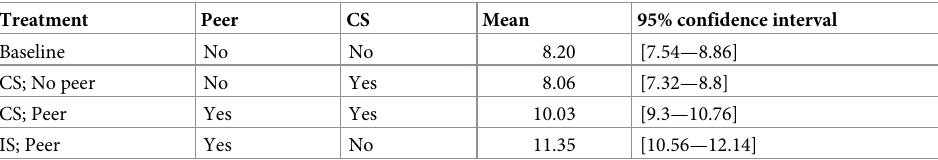
Table 3. Mean contributions in